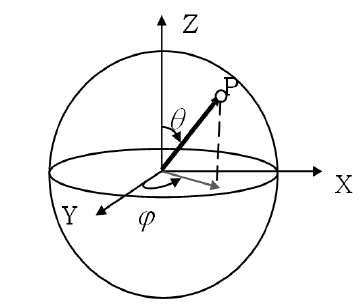
Figure 1. TLS Intrinsic Coordinates